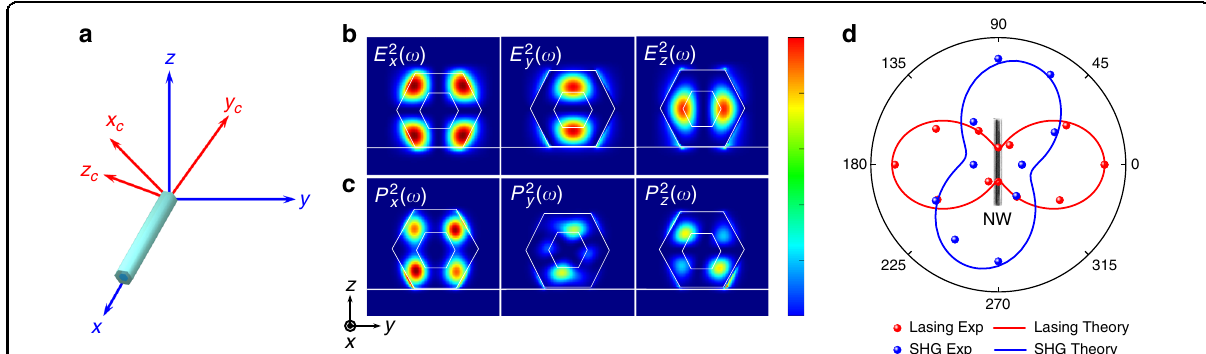
Fig. 4 Theoretical modeling and experimental results of the frequency-doubled mode. a Schematic of the lab frame ( xyz ) and the crystal frame ( x c y c z c ). b Electric fi eld distribution of the HE21 b mode of the NW in the yz plane, and its x , y , and z components. c Calculated second-order nonlinear polarization according to the electric fi eld of the HE21 b mode and second-order nonlinear susceptibility tensor of the GaAs. d Polarization dependence of the frequency-doubled lasing mode (blue dots) and its theoretical prediction (blue line), where the corresponding polarization dependence of the fundamental lasing mode is also shown (red dots for experimental results and red line for theoretical